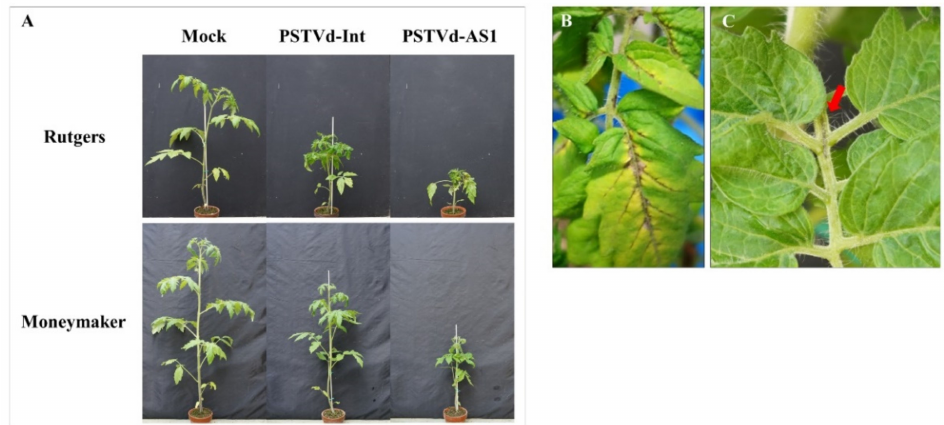
Figure 1. Symptoms in ‘Rutgers’ and ‘Moneymaker’ tomatoes infected with potato spindle tuber viroid (PSTVd). ( A ) At 3 weeks post-inoculation (wpi), PSTVd-infected ‘Rutgers’ tomatoes showed severe stunting and leaf curling. At 4 wpi, ‘Moneymaker’ tomatoes showed stunting during PSTVd infection, and mild leaf curling was observed only in PSTVd-AS1 infection. ( B,C ) Severe stem and vein necrosis, accompanied by yellowing or mild stem necrosis (indicated with a red arrow), was observed in ‘Rutgers’ and ‘Moneymaker’ tomatoes, respectively, after PSTVd-AS1 infection.